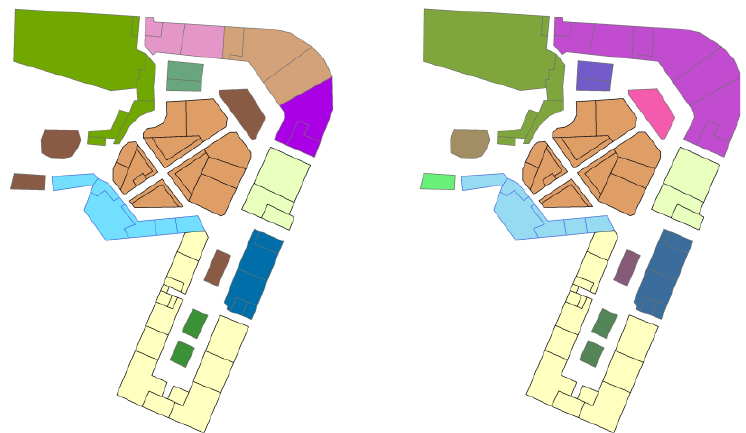
Figure 6. Clustering results of a sample (left: RGCN model, right: expected result).